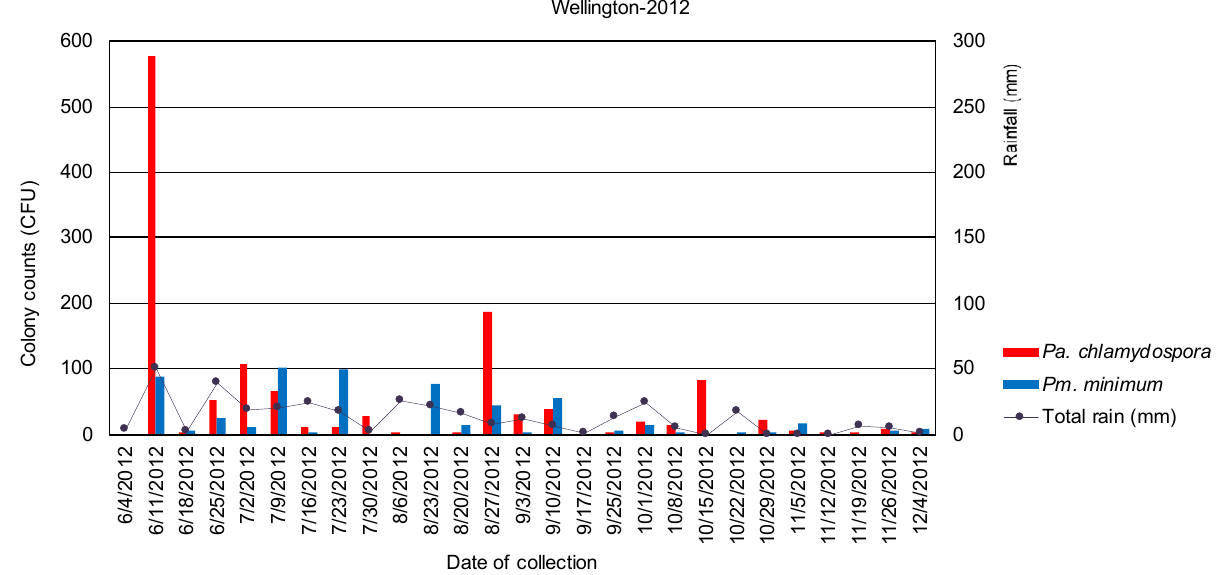
Figure 15. Phaeomoniella and Phaeoacremonium spp. cfu cultured from five vaseline coated microscope slides affixed to each of five root- stock mother vines in a rootstock mother block in Wellington, Western Cape province in 2012. The slides were replaced weekly. Each bar represents the total number of cfu cultured on three Petri